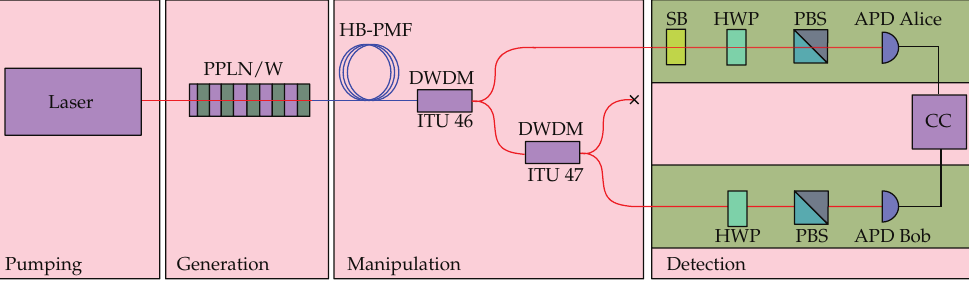
Figure 3: Layout of the